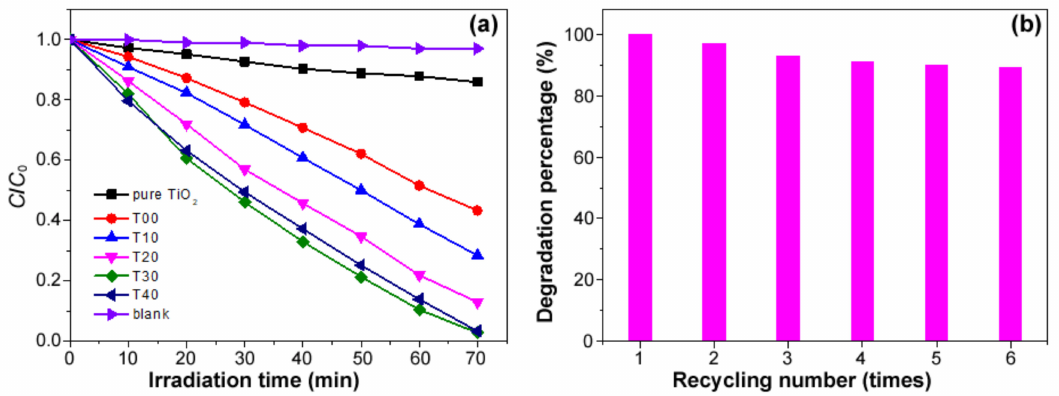
Figure 7. ( a ) Photocatalytic performance of the different samples; ( b ) recyclability of T30 in degrada- tion of Rhodamine